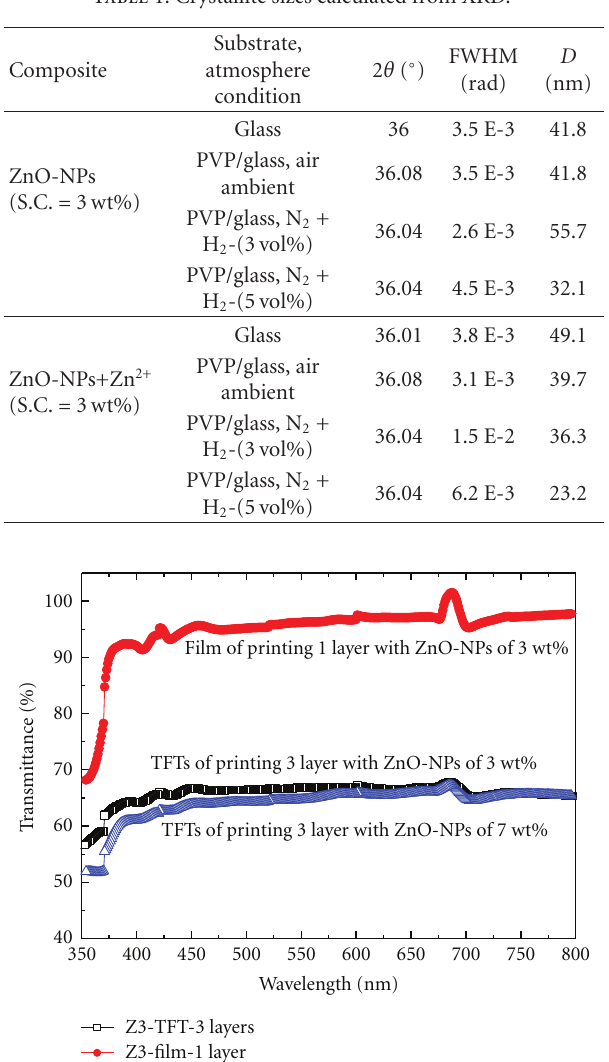
Table 1: Crystallite sizes calculated from XRD.